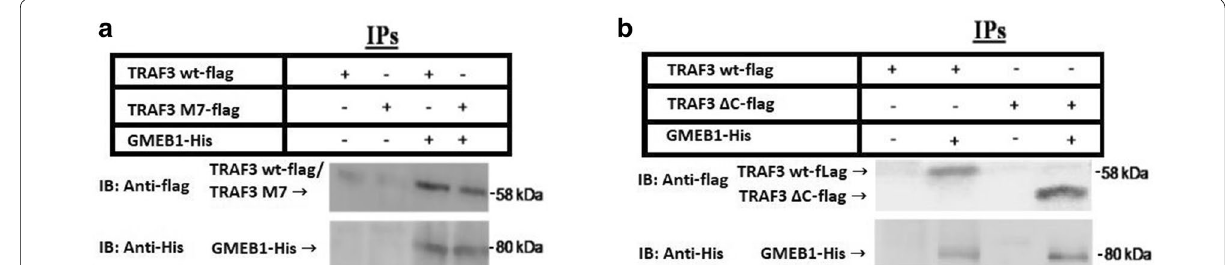
Fig. 2 Co-immunoprecipitation of TRAF3 and GMEB1 in mammalian cells. HEK293 cells were cotransfected with vectors expressing a His-tagged GMEB1 protein (GMEB1-His) (1 μg) together with ( a ) a FLAG-tagged TRAF3 protein (TRAF3 wt-flag) (0.5 μg) or a FLAG-tagged mutant TRAF3 M7 (TRAF3 M7-flag) (0.5 μg), defective in the RING domain. b a truncated TRAF3 (TRAF3ΔC-flag) (0.5 μg), which is lacking the TRAF-C domain. 24 h post transfection, the cell extracts were subjected to immunoprecipitation using the Ni–NTA beads (Qiagen), which bind to GMEB1-His. The immunoprecipitated complex (IP) was analyzed by SDS-PAGE on a 7.5% gel and subjected to immunoblot analysis with an anti-His rabbit polyclonal antibody recognizing GMEB1 (His probe) (80 kDa) or with an anti-flag mouse monoclonal antibody recognizing both TRAF3 wt (58 kDa) and TRAF3